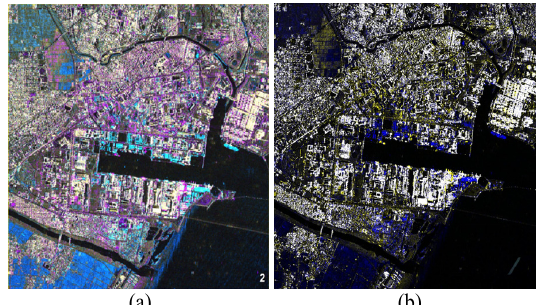
Figure 3. (a) A cut-out of the thematic map covering Sendai harbor. (Magenta: destroyed buildings or debris; Bright blue: structural damages across harbor; Dark blue: flood area) (b) The false-color image within the same range of (a). The representations of yellow, bright blue and dark blue in (b) are corresponding to the ones of Magenta, bright blue and dark blue in